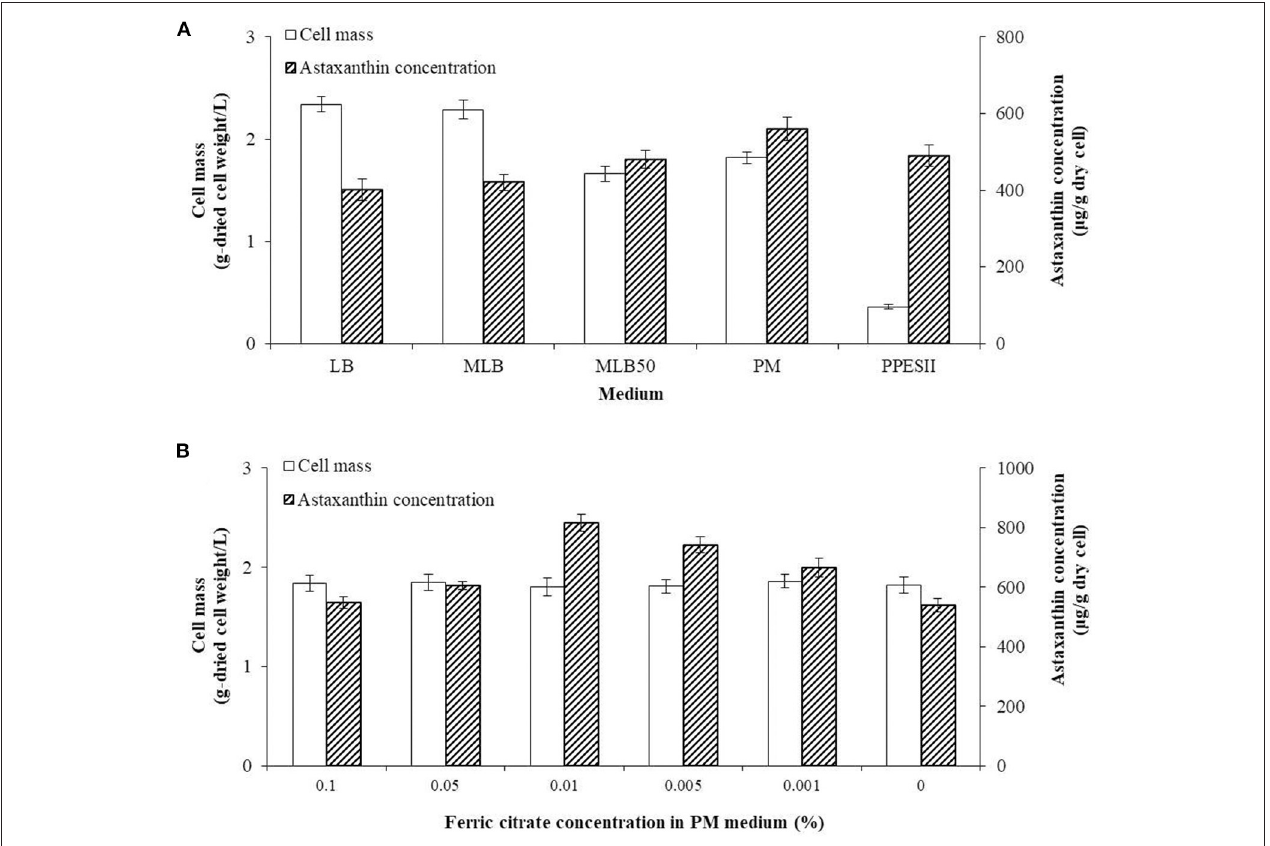
FIGURE 3 | Comparison of cell mass and astaxanthin concentration by medium composition. (A) Optimizing the concentration of the dried cell mass and astaxanthin by varying the type of medium. (B) The concentration of the cell mass and astaxanthin produced after varying the concentration of ferric citrate in the PM